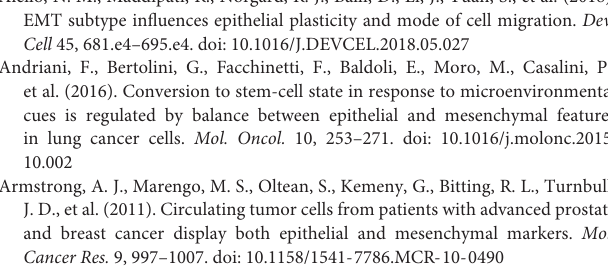
FIGURE S3 | EMT score correlation with TGF β -specific EMT scoring method in CCLE dataset. (A) Pearson’s correlation coefficient and (B) Spearman’s correlation. Correlation coefficient ( R ) and p -value ( p ) reported in each plot. FIGURE S4 | EMT scores of different EMT time series datasets and CTCs. (A) GSE24202 – EMT induction by different EMT regulators. (B) GSE84002 – EMT and MET induction over time by GFP, SNAI1 and SNAI2. (C) GSE43489 – EMT/MET induction in PC3 cell line. (D) GSE17708 – EMT induction over time. (E) GSE55470 – CTCs from breast cancer patients. (F) GSE50991 – CTCs from ex vivo lung cancer model ( ∗ p < 0.05, n = 3, two-tailed Student’s t -test; error bars represent standard deviation for n = 3). Graphs (E) and (F) represent kernel density plots. FIGURE S5 | (A) Scatter plot showing 100 farthest and closest samples based on the distance from mixture curve defined by median of 35 most pure E and pure M CCLE samples. (B) MLR EMT score for N (10,20,50,100) closest and farthest hybrid samples from median mixture curve. Bar plots showing EMT scores of N (10, 20, 50, 100) closest and farthest hybrid samples from mean mixture curve. (C) 76GS EMT score and (D) KS EMT score. Bar plots showing EMT scores of N (10, 20, 50, 100) closest and farthest hybrid samples from median mixture curve. (E) 76GS EMT score (F) KS EMT score ( ∗ p < 0.05, N = 10, 20, 50, and 100, two-tailed Student’s t -test; error bars represent standard deviation for the given value of N ).